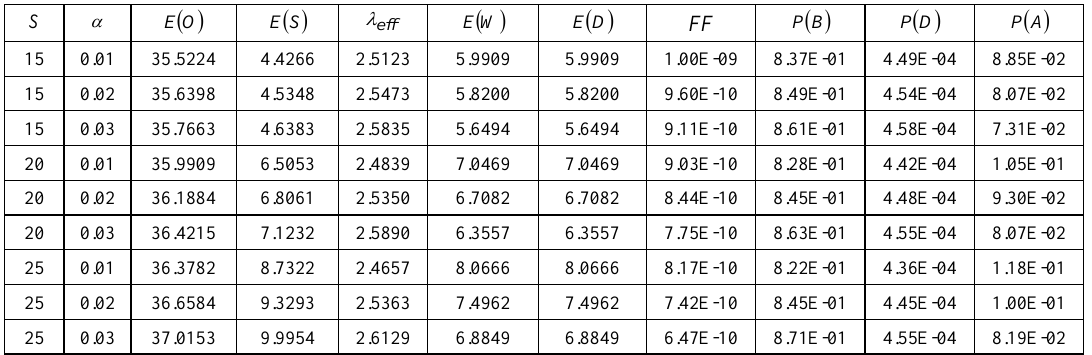
Table 3. Performance measures by varying the number of standby machines ( ) S and the failure rate of standby machine ( )  .